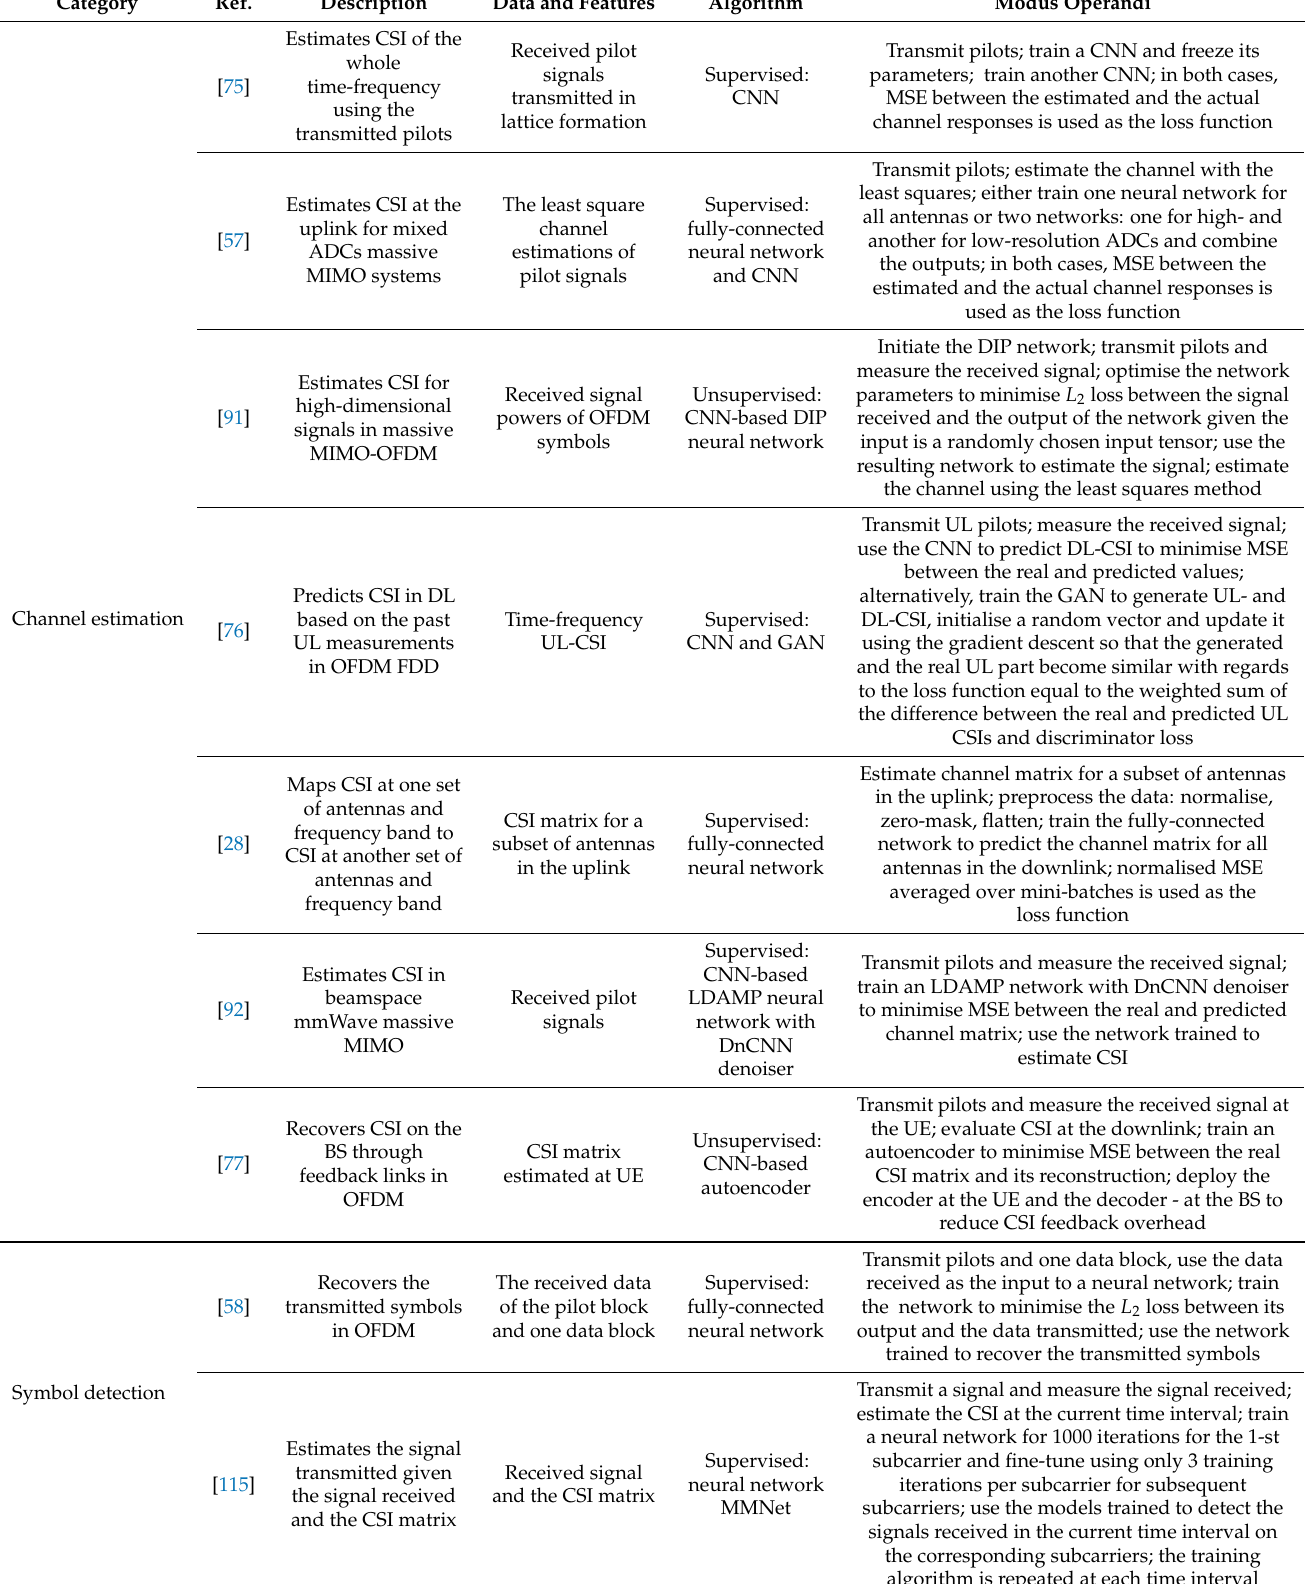
Table 3. AI/ML applications in mobile